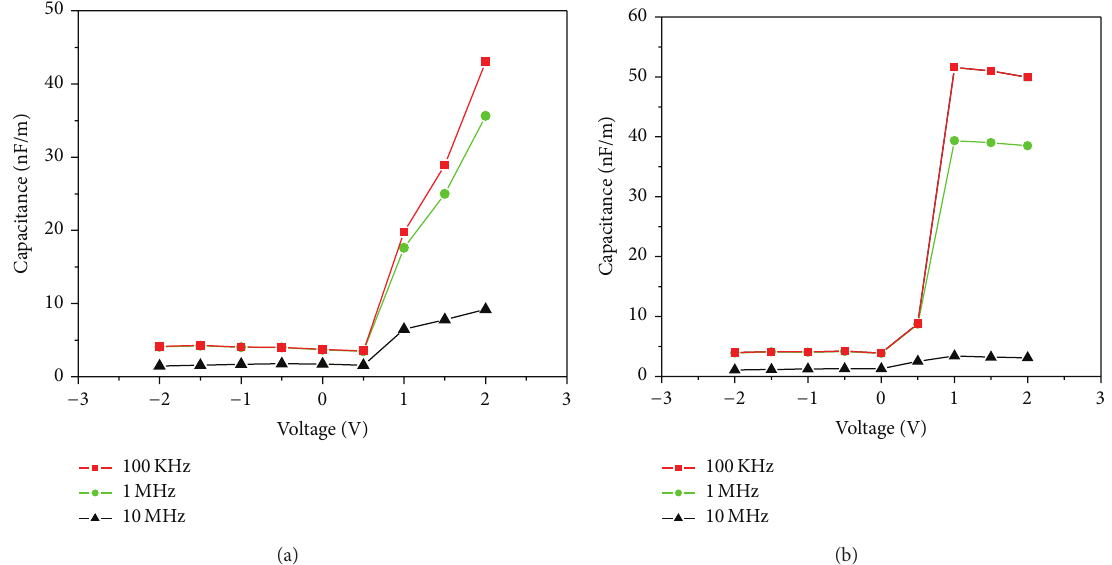
Figure 6: (a) 𝐶 - 𝑉 simulation figure of the InGaAs QD RCE photodetector under different frequents. (b) 𝐶 - 𝑉 characteristics of the InAs QD RCE